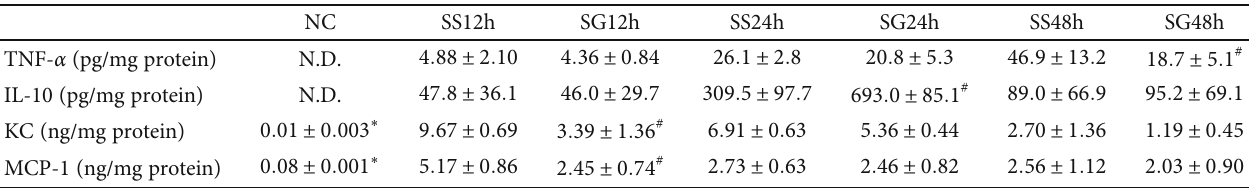
Table 4: The concentrations of in fl ammatory cytokines and chemokines in peritoneal lavage fl uid. NC SS12h SG12h SS24h SG24h SS48h SG48h TNF- α (pg/mg protein) N.D. IL-10 (pg/mg protein) N.D. MCP-1 (ng/mg